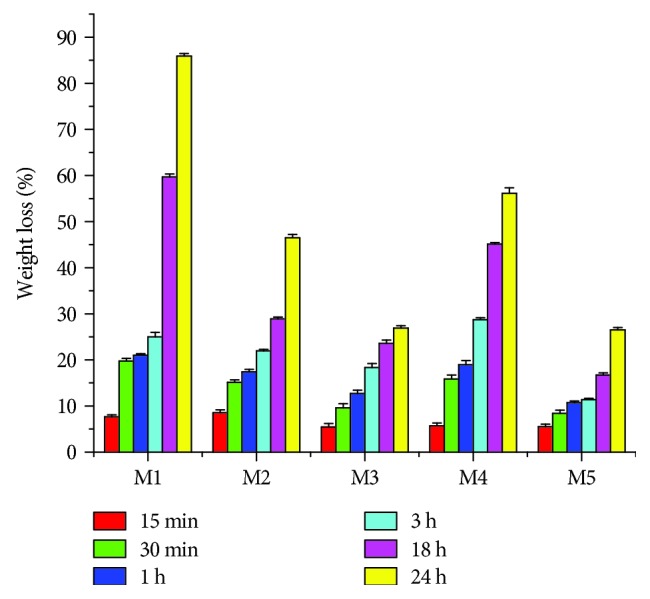
Enzymatic degradation of multiparticulate systems.